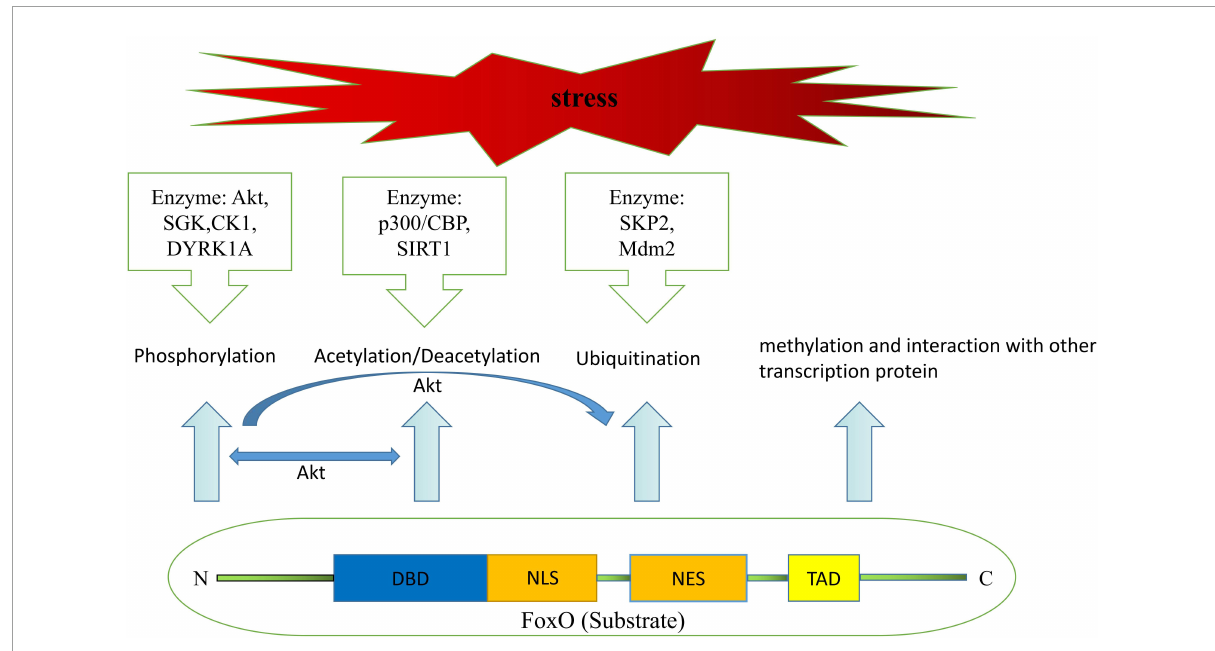
FIGURE1 Structural components of FoxO protein and mechanisms leading to post-translational modifications of